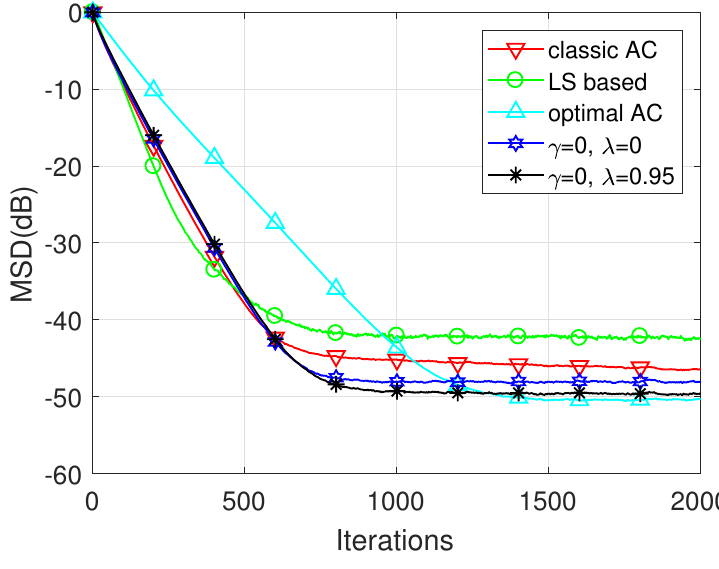
Figure 7. The MSD learning curves for the sparse